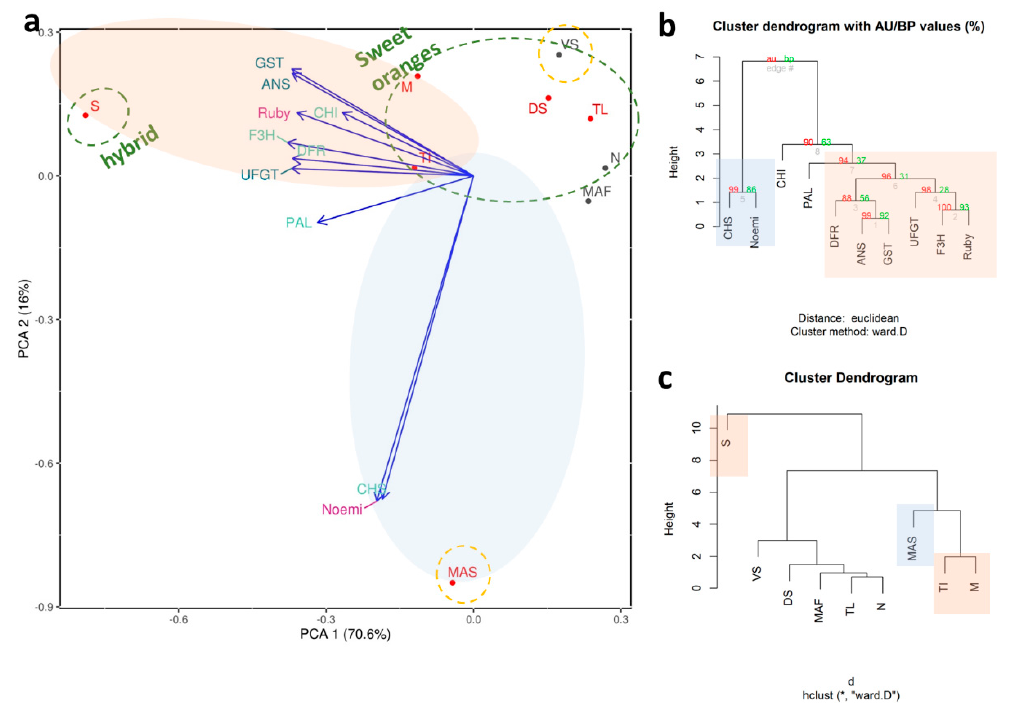
Figure 10. Statistical analysis of accessions selected for their pigmentation in flesh and juice. ( a ) Principal component analysis, cluster dendrogram based on the distribution of expression data focused ( b ) on genes and ( c ) on accessions. Accessions are coded: ‘Faustrime’—MAF, ‘Navel’—N, M.